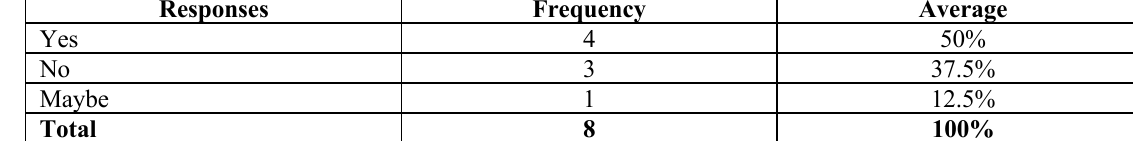
Table 24. Do you think the amount of 10,000php was enough as a complementary